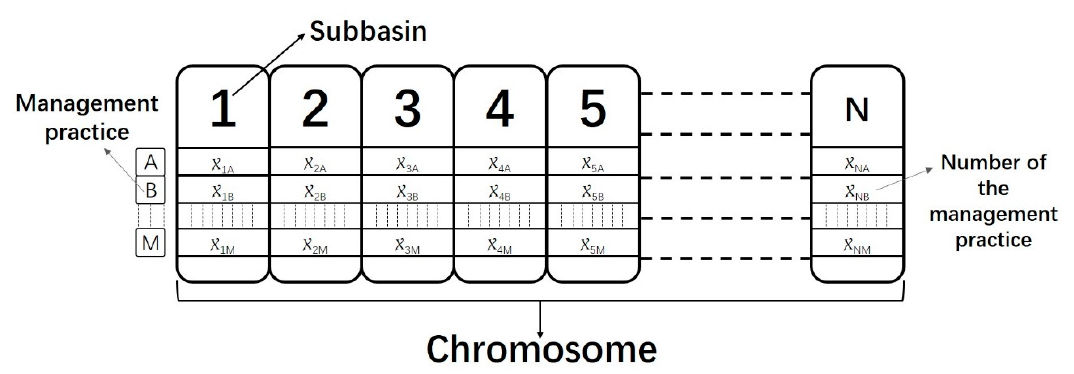
Figure 2. Gene string (chromosomes) for best management practices (BMPs) optimization in the watershed.